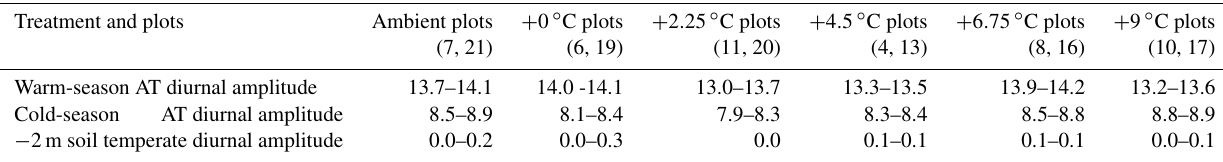
Table 2. Range of diurnal air temperature amplitudes (AT, ◦ C) at + 2m in warm (DOY 230 to 300) and cold (DOY 300 to 365; 1 to 13) seasons, and the mean diurnal soil temperature amplitude (ST, ◦ C) at − 2m for a period including the warmest and coldest extremes of the measurement period (August 2015–January 2016).